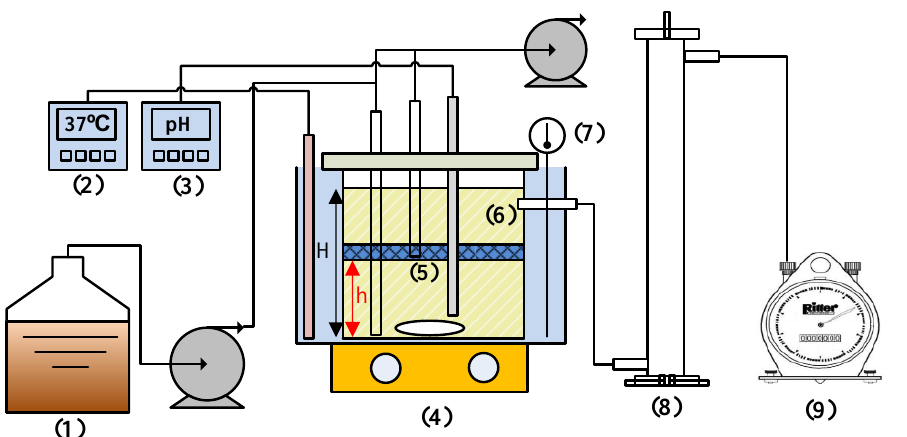
Figure 1. Schematic diagrams of an experimental process for M365-Blue bioreactor (M365-Blue). (1) Medium tank, (2) Temperature meter, (3) pH meter, (4) Magnetic stirrer, (5) Packed-Filter (h/H-1/2) (h: height from the bottom of the bioreactor; H: total height of working volume of the bioreactor), (6) H 2 fermenter, (7) Thermometer, (8) Gas–liquid separator, (9) Wet gas meter.